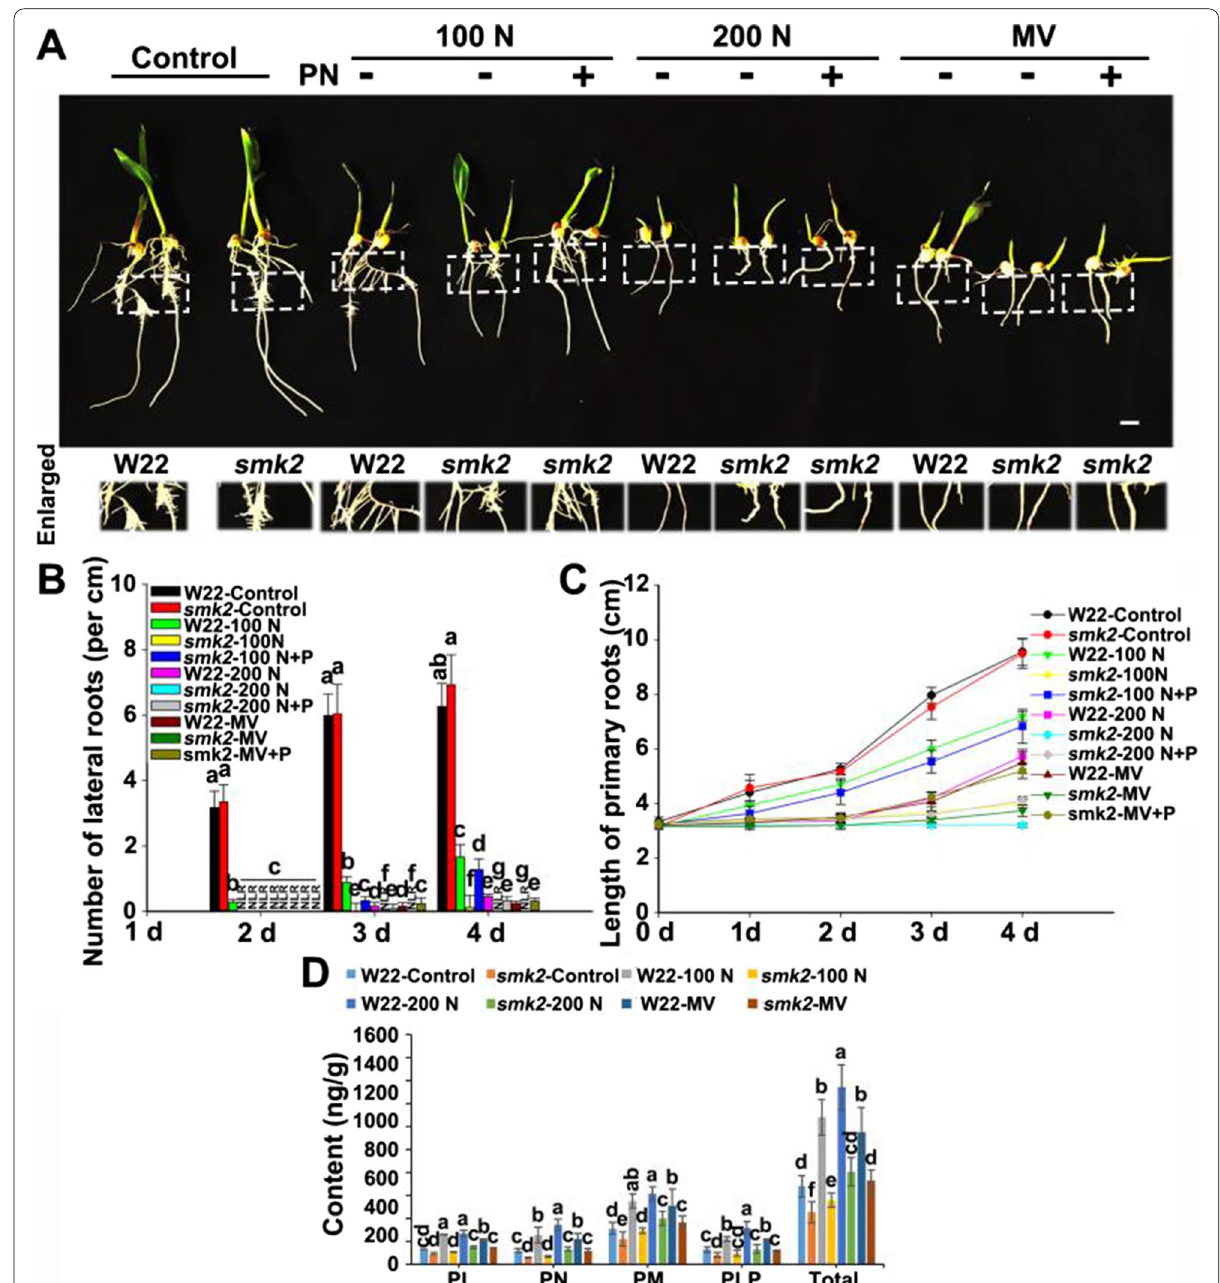
Fig. 4 smk2 heterozygous plants were more sensitive than the W22 plants to salt stress. A Phenotypes of W22 and smk2 heterozygous suffered from H 2 O (Control), 100 mM NaCl (N), 200 mM NaCl and 10 μM MV (methyl viologen), white dotted lines show the enlarged part. B LRs number of (A) after different treatments for 4 d. LRs are from independent maize seedling ( n C The PRs length of (A) after different treatments for 4 d. PRs are from independent maize seedling ( n PL, PN, PM, and PLP after different treatments for 24 h in W22 and smk2 heterozygous plants. The different letters represent significant differences ( P < 0.05, based on one-way